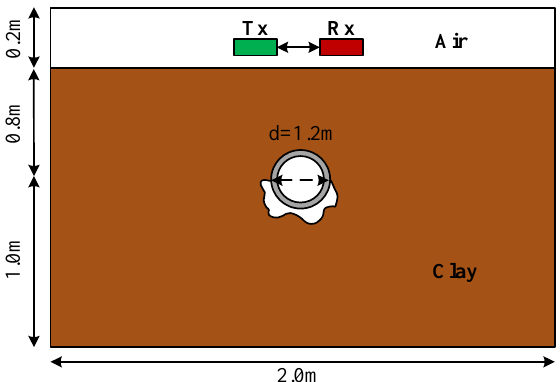
Figure 8. Schematic diagram of model with cavity disease on the upper part of pipeline.